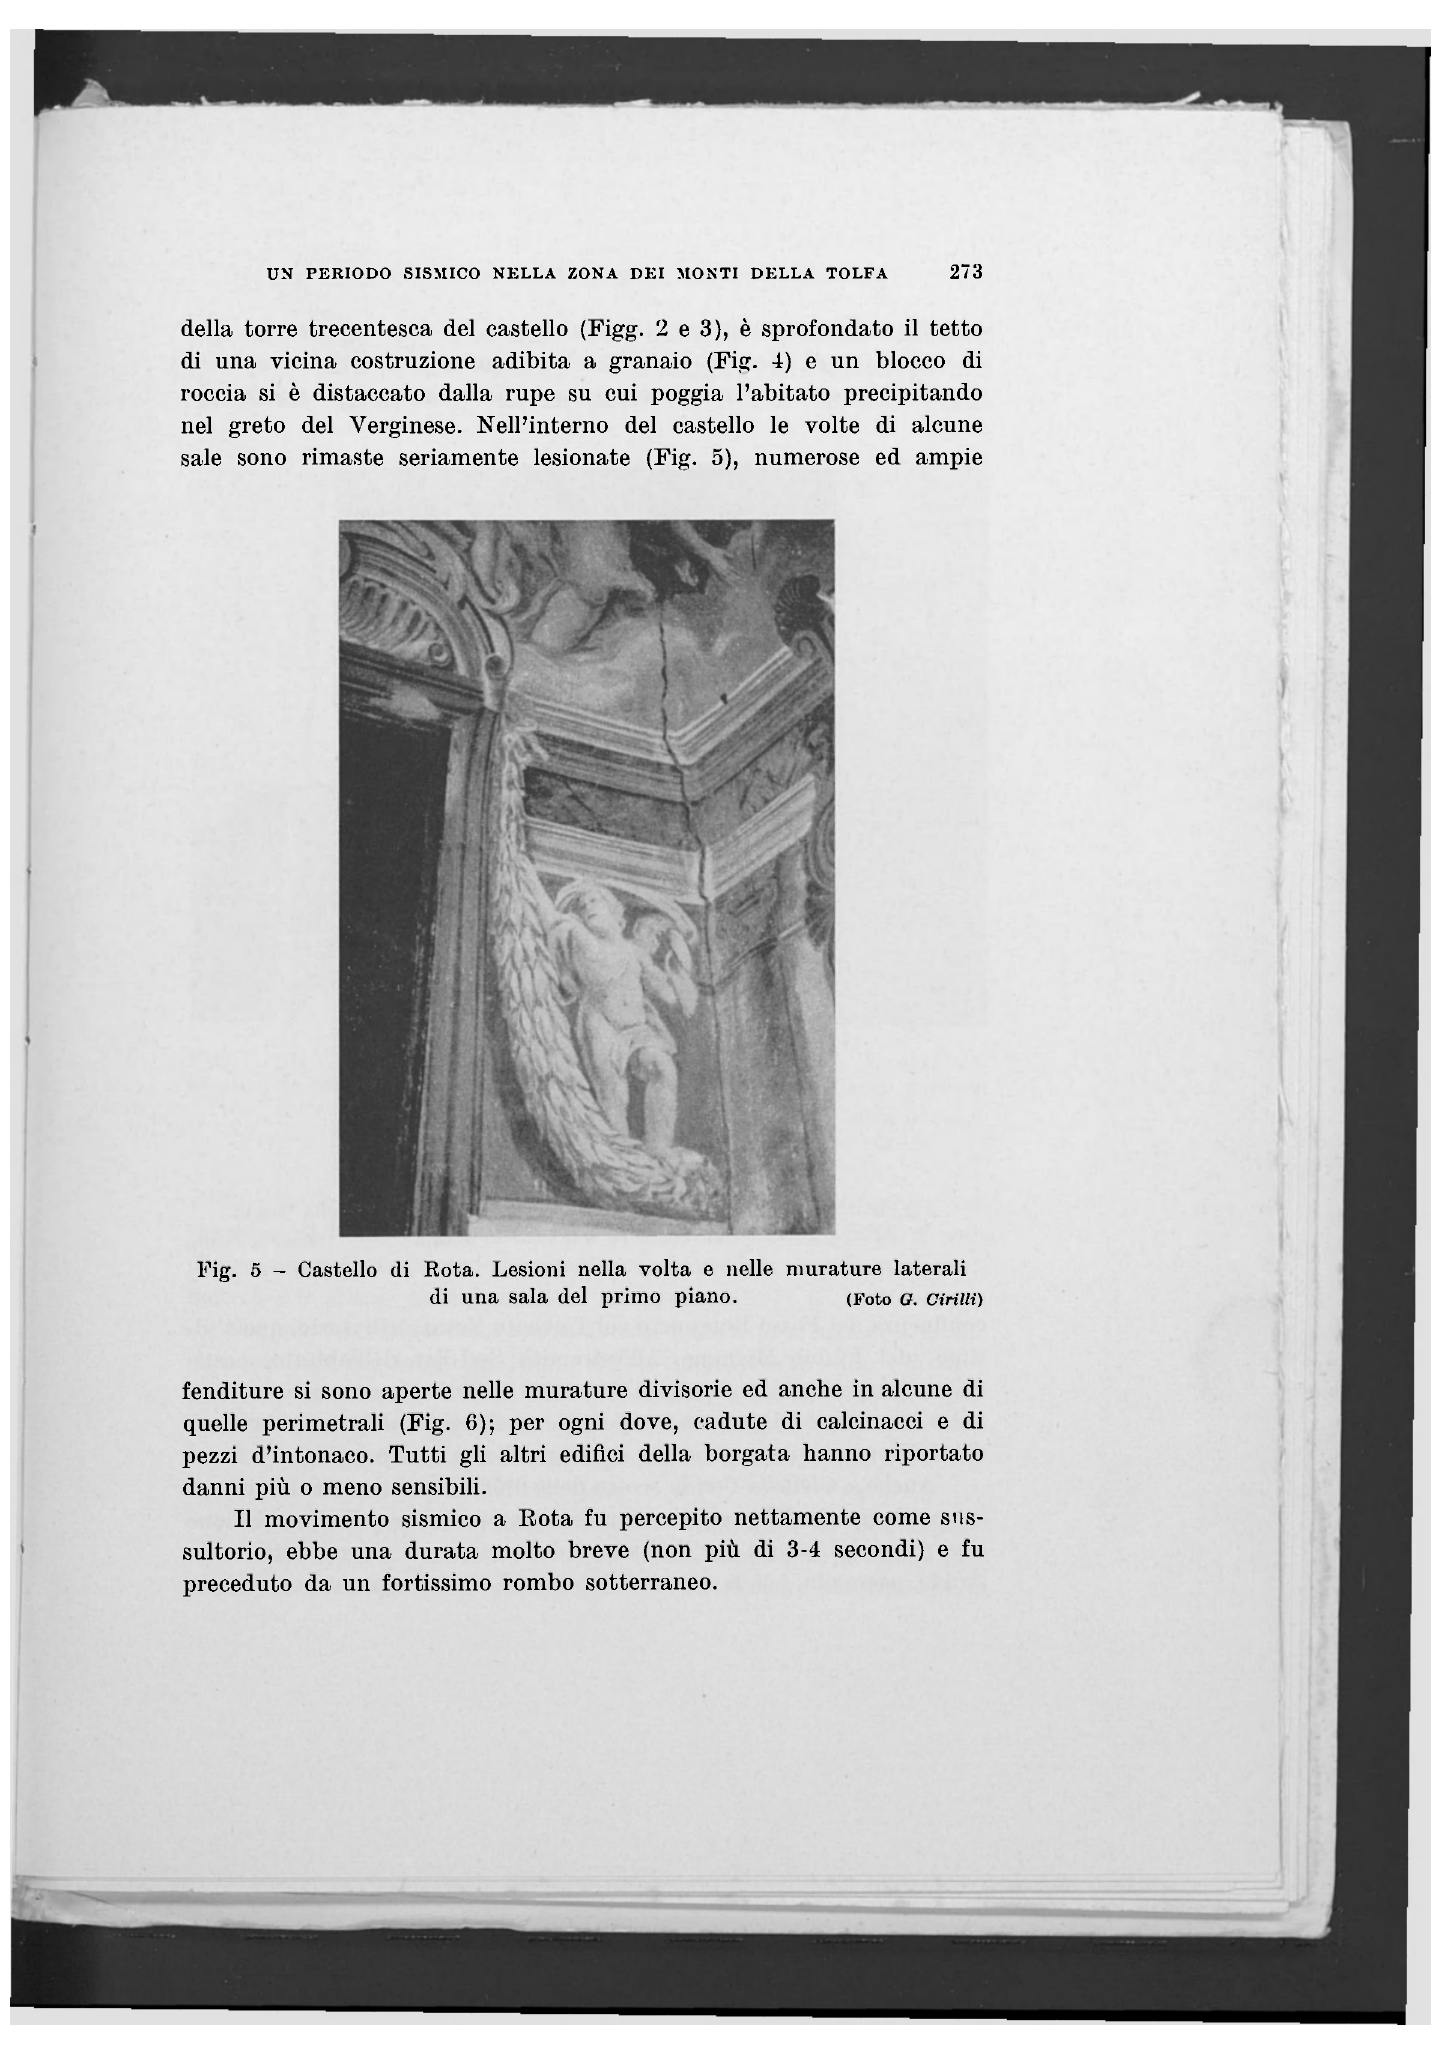
Fig. 5 - Castello di Rota. Lesioni nella volta e nelle murature laterali di una sala del primo piano. (Foto a.